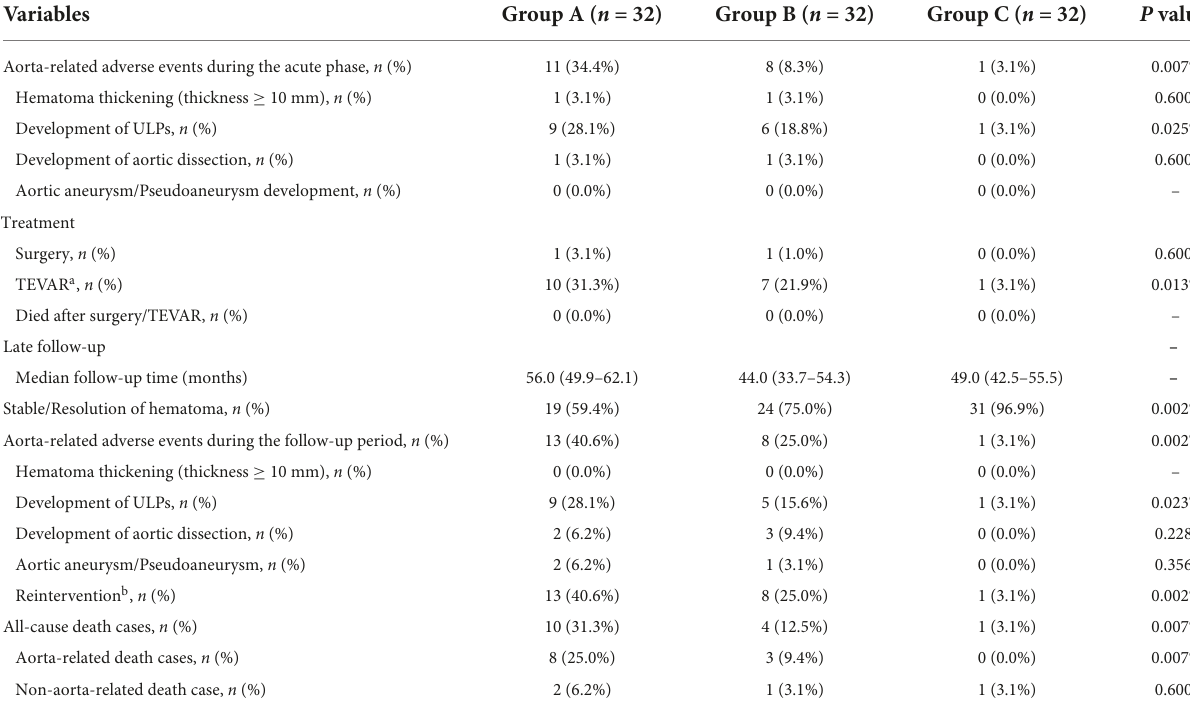
TABLE 2 Disease progressions, treatments and